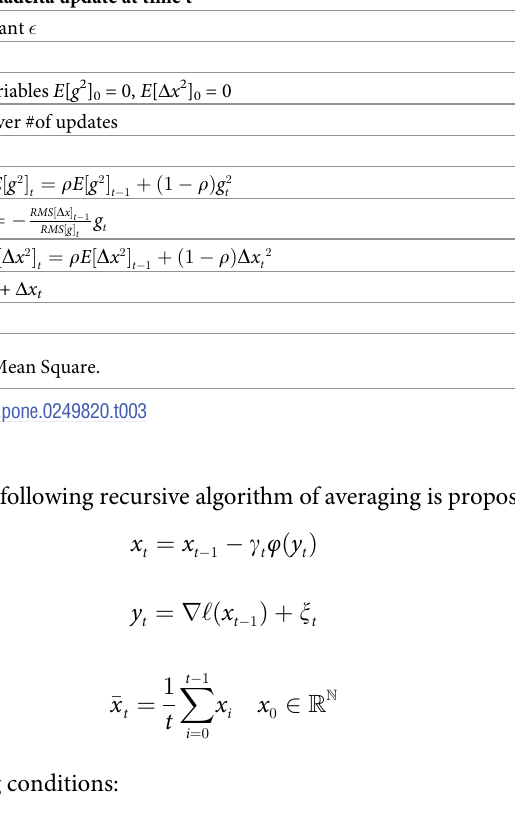
Table 3. The pseudocode of Adadelta optimization algorithm. Algorithm 1 Computing Adadelta update at time